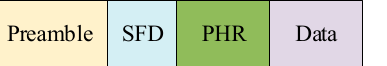
Figure 3. The frame structure of the physical layer.